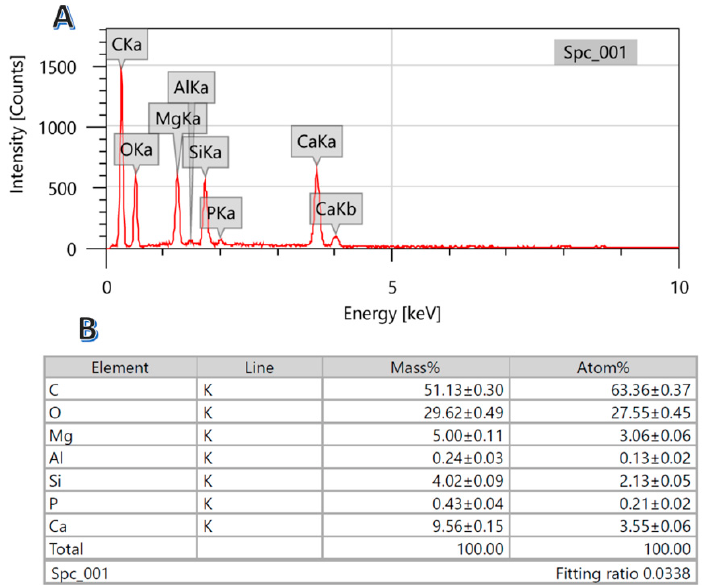
Figure 2. EDS spectrum; ( A ) and elemental analysis; ( B ) for a powder produced from hydrothermal treatment using 3.0 M KOH at 150 °C for 6 h and calcined at 800 °C.